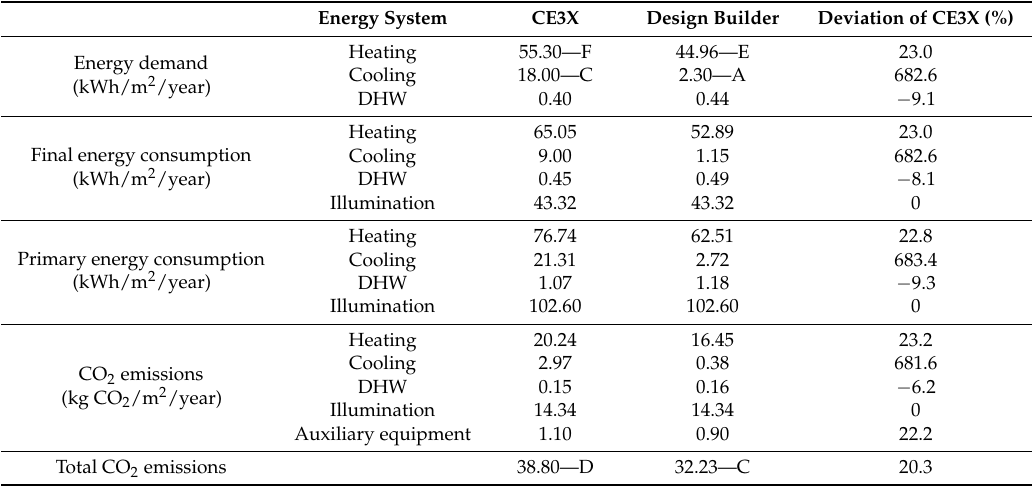
Table 3. Energy consumption parameters obtained by Design Builder and CE3X, and the CO 2 emissions derived from them. The letters represent the level of the energy efficiency according to